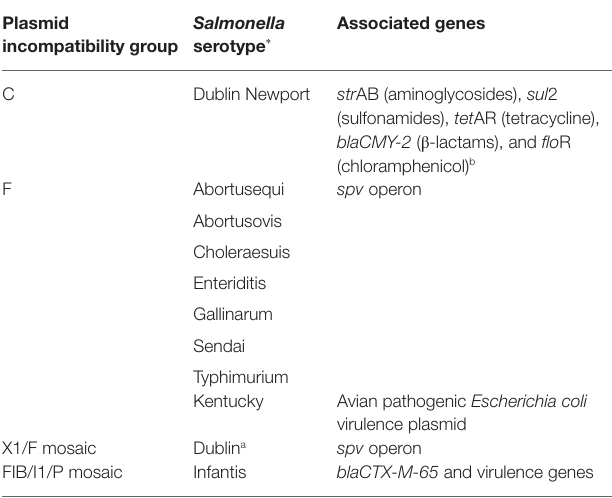
Salmonella serotype